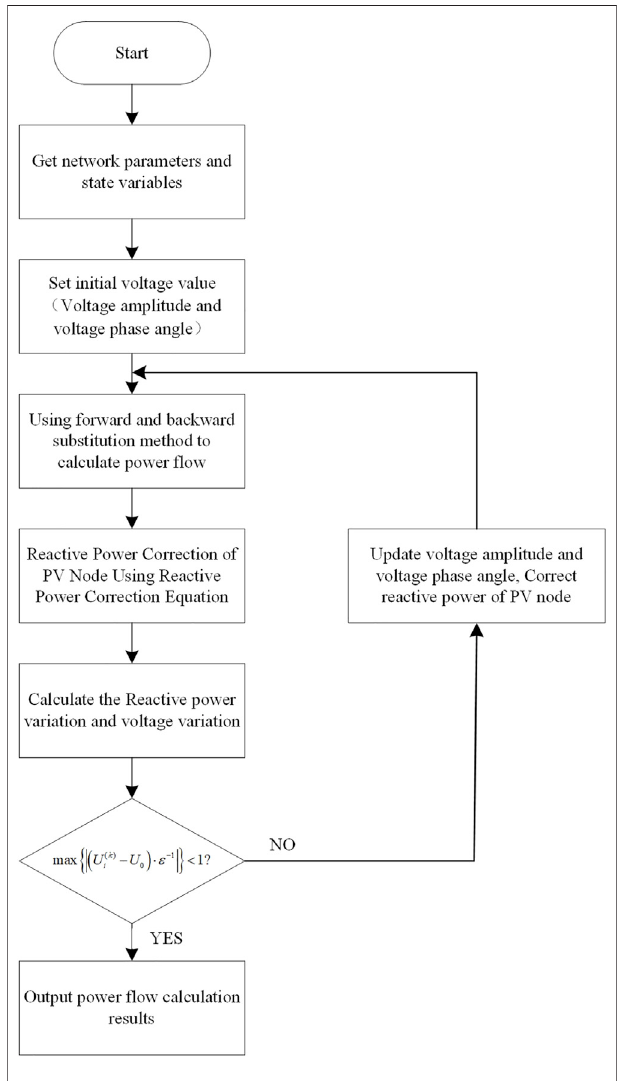
FIGURE 2 | Flow chart of the power fl ow